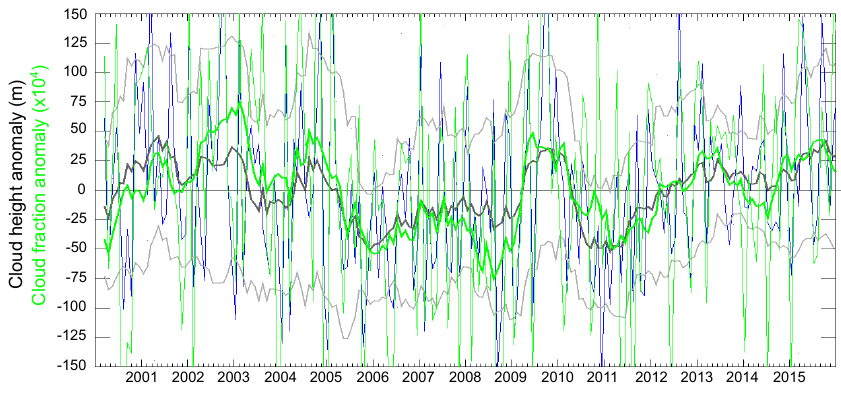
Figure 7. CALIOP-derived cloud fraction over the Southeast US (SEUS) for 2007 through 2014 showing no evident trend during the period.